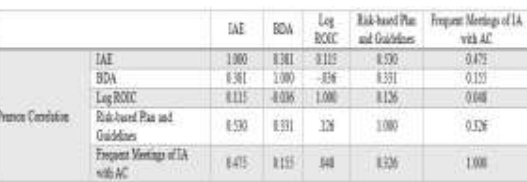
Table 3: Correlations